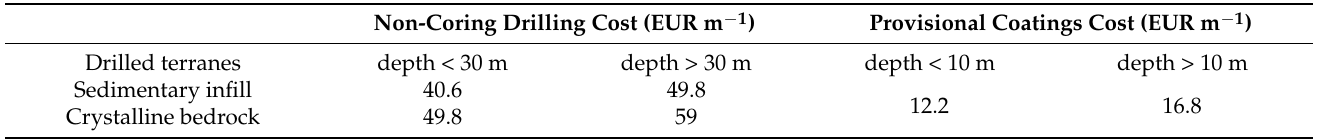
Table 2. Costs (EUR m − 1 ) of non-coring drilling and provisional coating (obtained from the price list of the Calabria